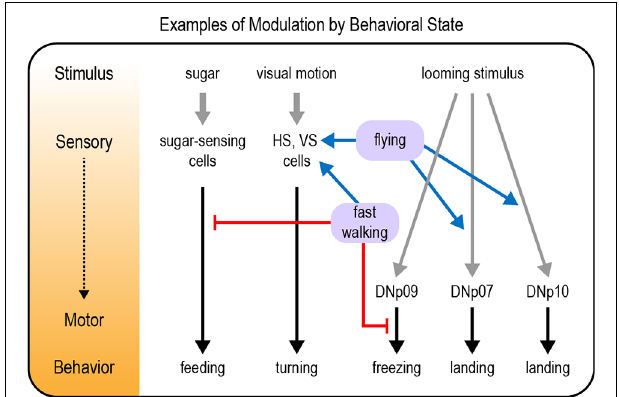
FIGURE 4 | Examples of modulation by behavioral state. Behavioral states such as walking or flying modulate neural pathways underlying a variety of behavioral responses, including feeding responses, visual motion processing, and responses to a looming stimulus. Modulation can occur at any level from sensory to motor processing (represented by the diagram and color gradient on the left). Gray arrows depict sensory input; black arrows depict neural circuits that generate behavior; blue arrows depict excitatory modulation whereas red arrows depict inhibitory